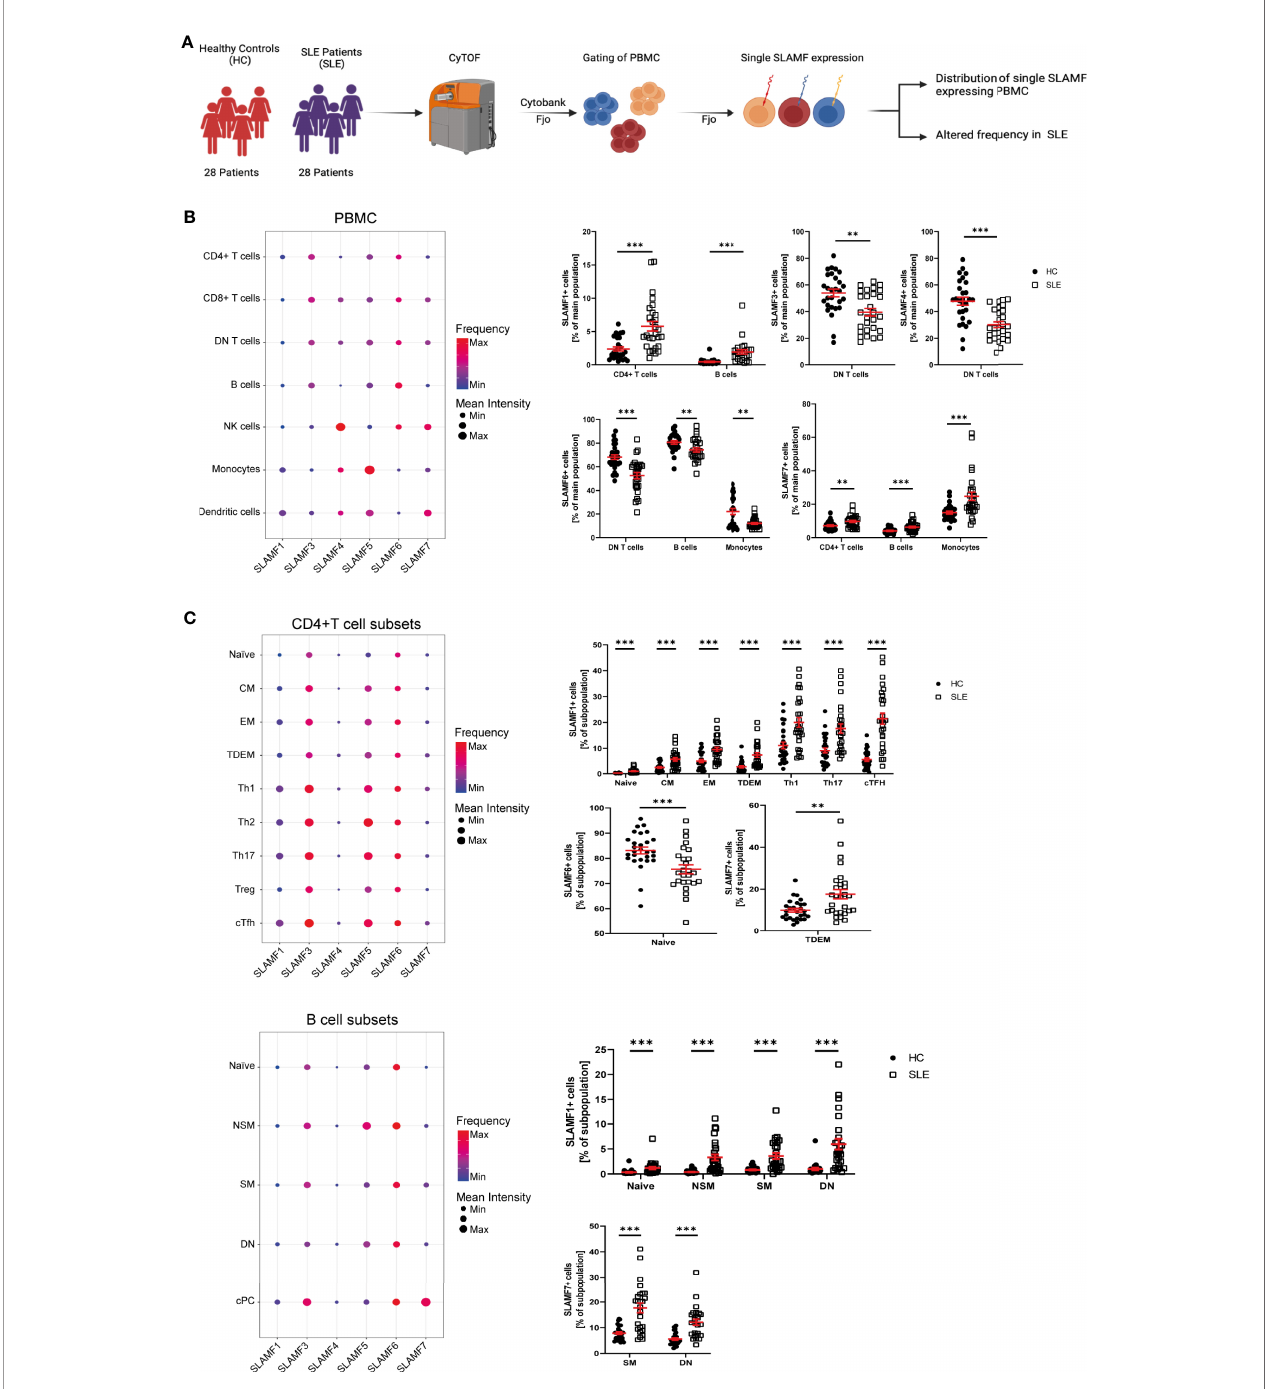
FIGURE 2 | Single SLAMF expression in SLE. (A) Graphical abstract of technical approach (B) Dotplot of SLAMF expression in main PBMC of SLE patients (frequency and mean intensity, left) and presentation of signi fi cant differences in frequency of single SLAMF expressing PBMC between HC and SLE patients (n=28, Welch ’ s T tests on log10 transformed data, right). (C) Dotplot of SLAMF expression in CD4+ T (top) and B (bottom) cell subpopulations of SLE patients (frequency and mean intensity, left) and presentation of signi fi cant differences in frequency of single SLAMF expressing subpopulations between HC and SLE patients (n=28 for CD4+ T cells and n=26 for B cells, Welch ’ s T tests on log10 transformed data, right). DN T, double negative T cells; CM, central memory cells; EM, effector memory cells; TDEM, terminally differentiated effector memory cells; Th1, 2, 17, T helper type 1, 2, 17 cells; cTFH, circulating T follicular helper cells; NSM, non-switch memory cells; SM, switch memory cells; DN, double negative B cells; cPC, circulating plasma cells; Min, minimum mean intensity of marker expression; Max, maximum mean intensity of marker expression. Data represent mean ± SEM (**p= 0.02, ***p <